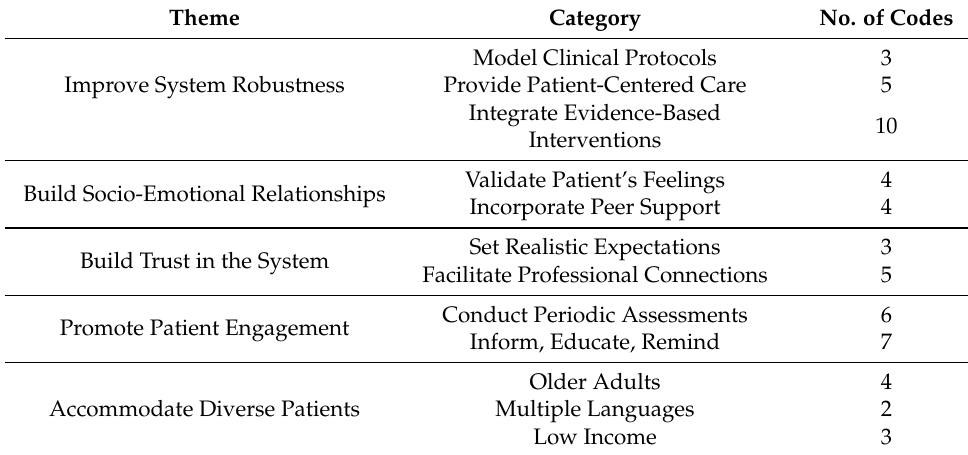
Table 3. Thematic Analysis Results from Study